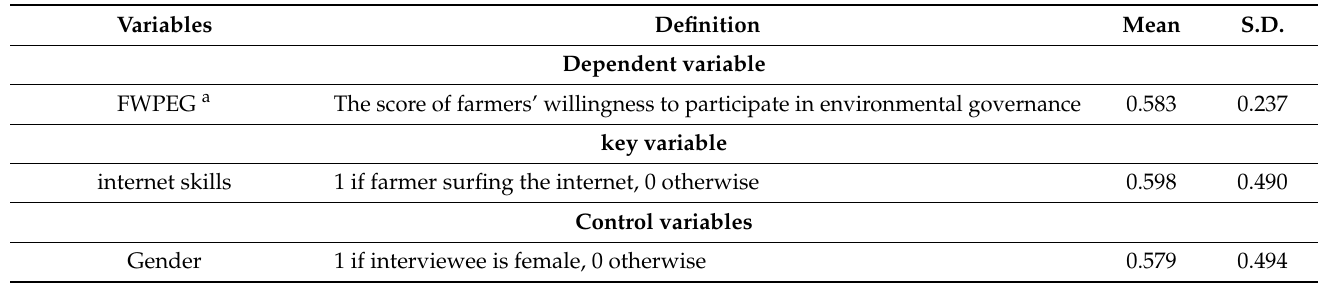
Table 2. Definition and data description of variables in